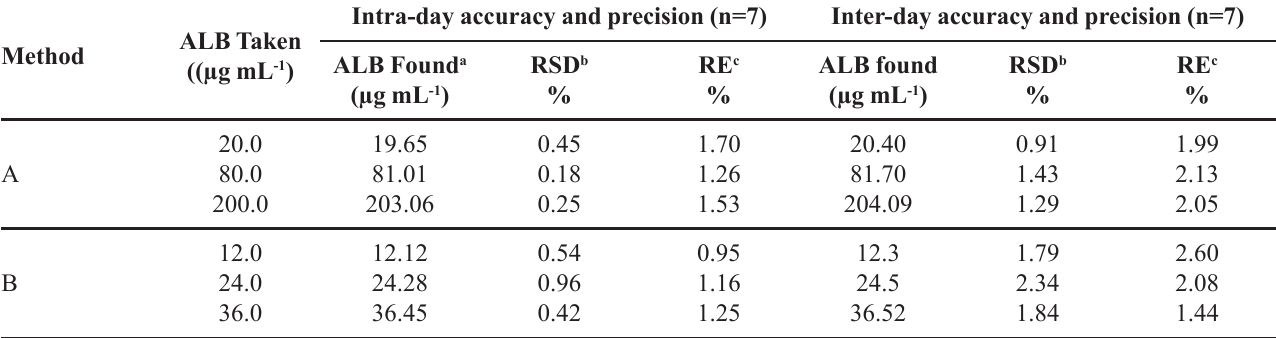
TABLE II - Evaluation of intra-day and inter-day accuracy and precision